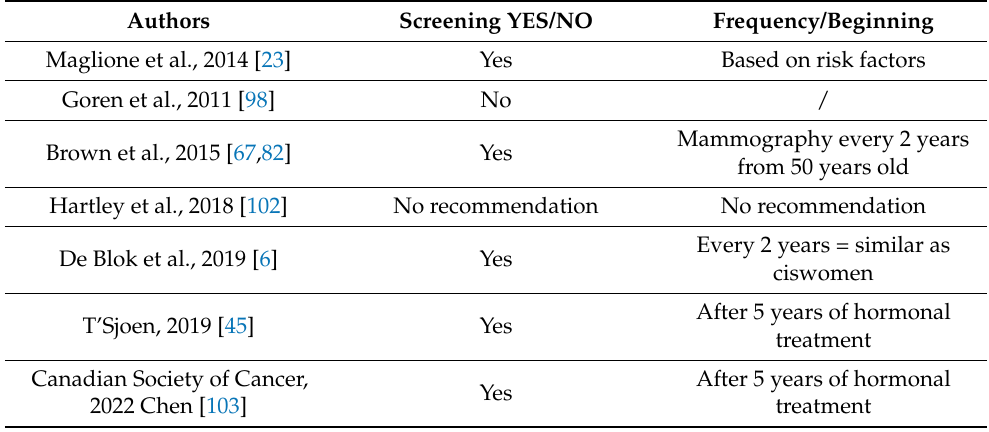
Table 2. Recommendations for screening and